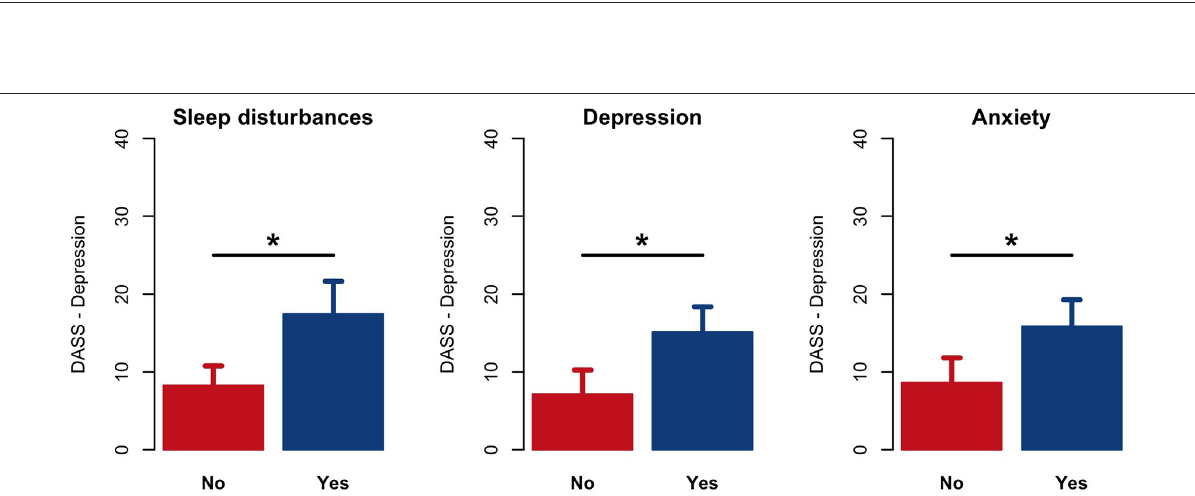
Frontiers in Psychiatry |